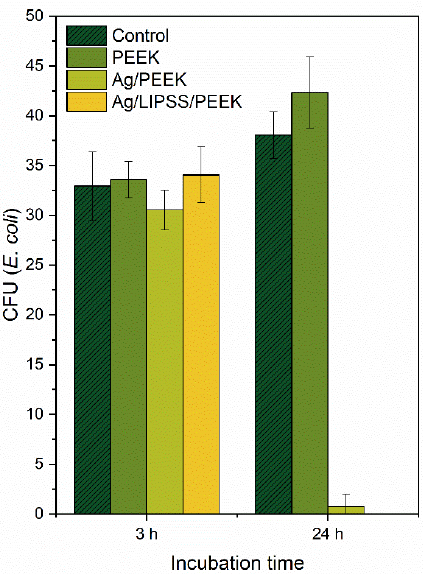
Figure 6. Viability of E. coli for different incubation times with Ag-treated PEEK expressed by the number of CFU, determined by the drop plate test.